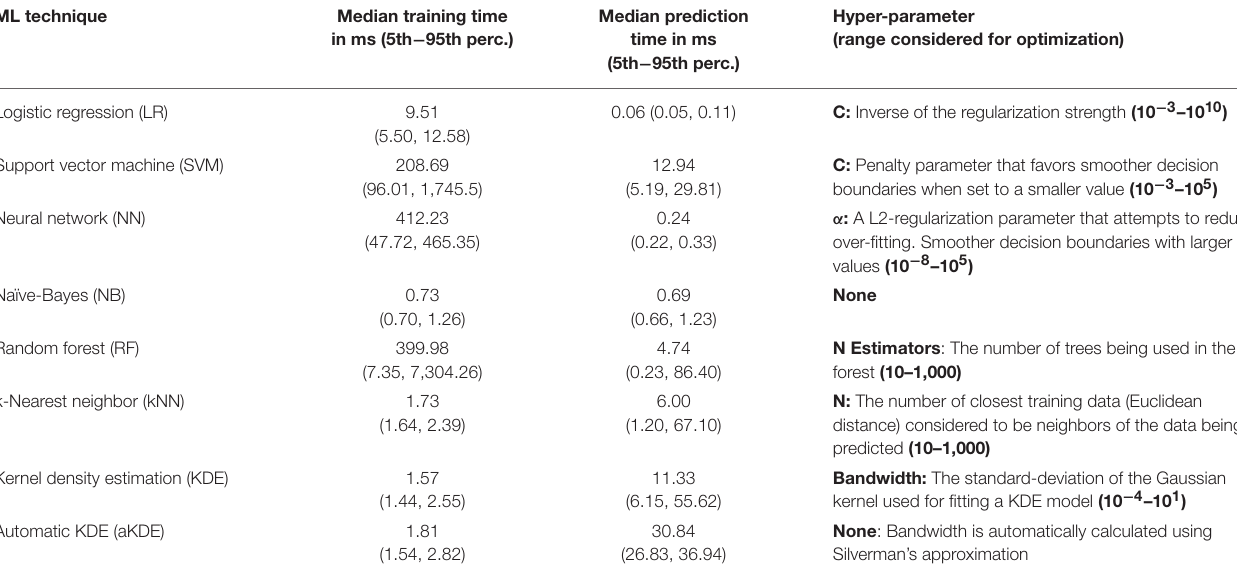
TABLE 1 | Median training and prediction times for each of the machine-learning techniques used in this study over the range of hyper-parameters tested (5th and 9th percentiles provided in parentheses). ML